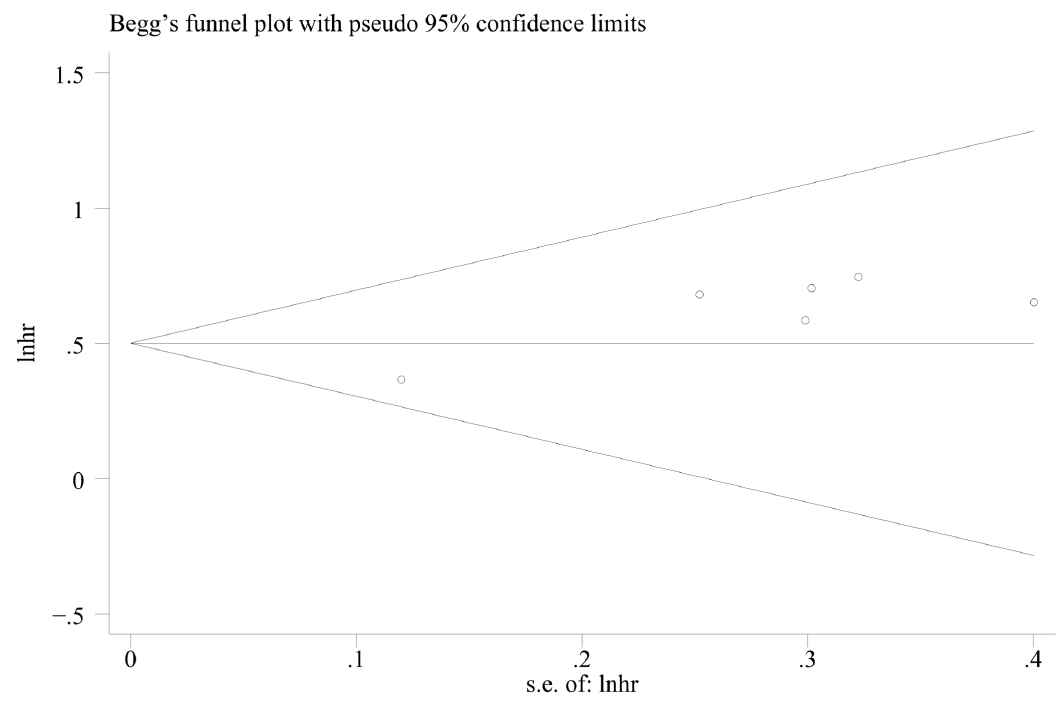
Figure 6. Funnel plot for hazard ratios of recessive model in OS studies.